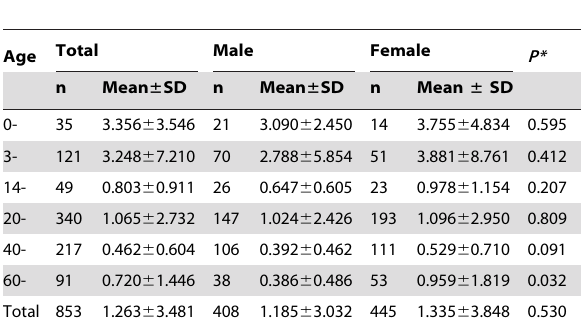
Table 5. Dietary Aluminium exposures (mg/kg bw/week) in Shenzhen population by age and sex